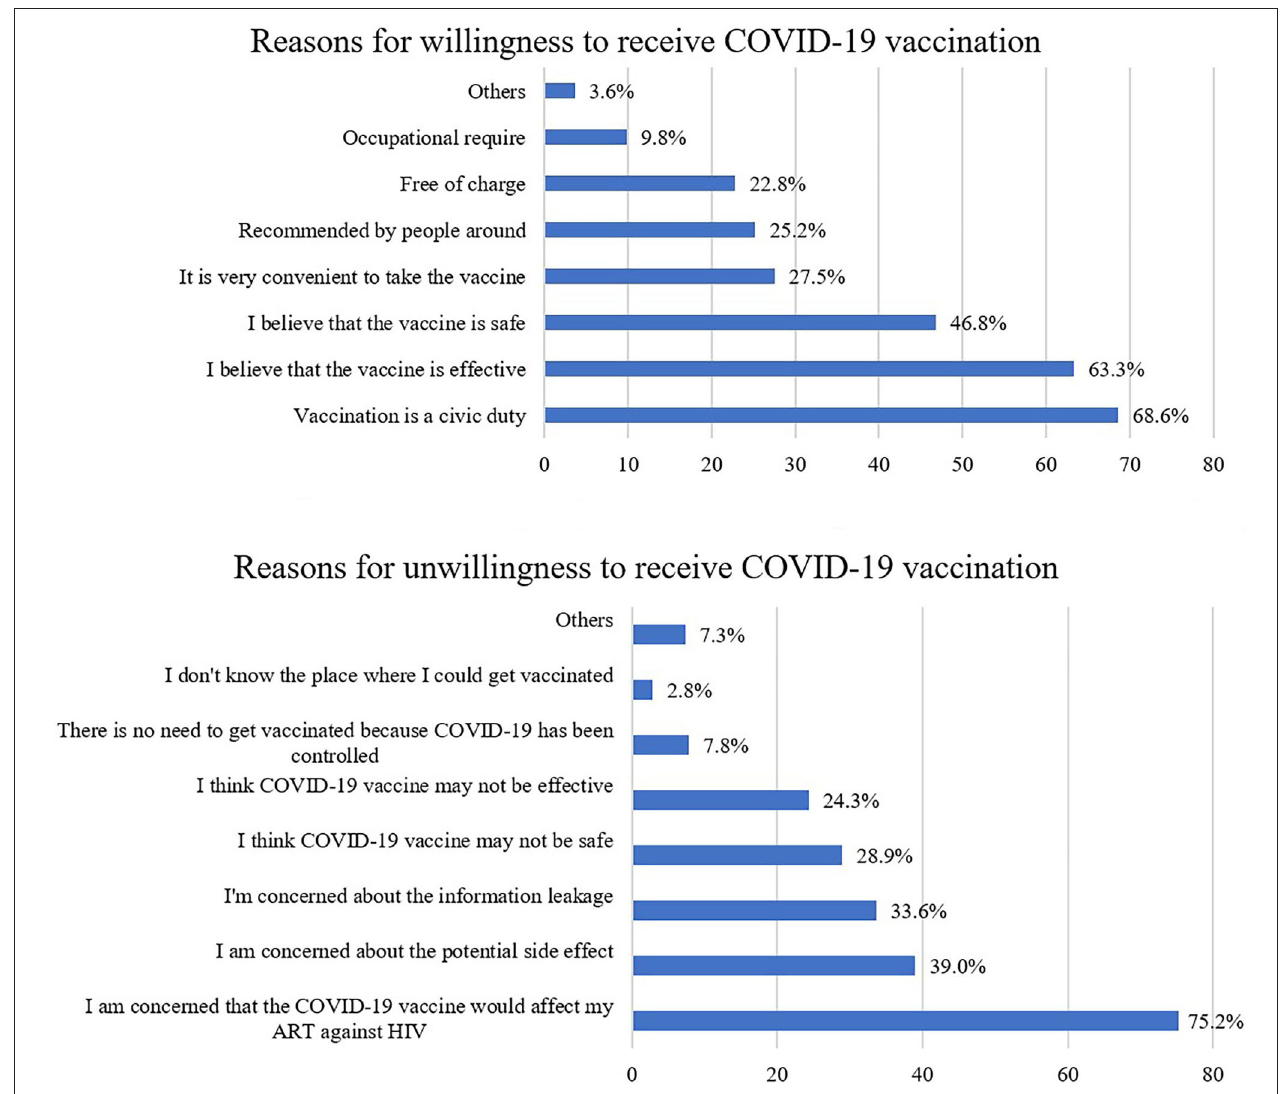
FIGURE 2 | Proportion of reasons for willingness and unwillingness to receive COVID-19 vaccination among PLWH.